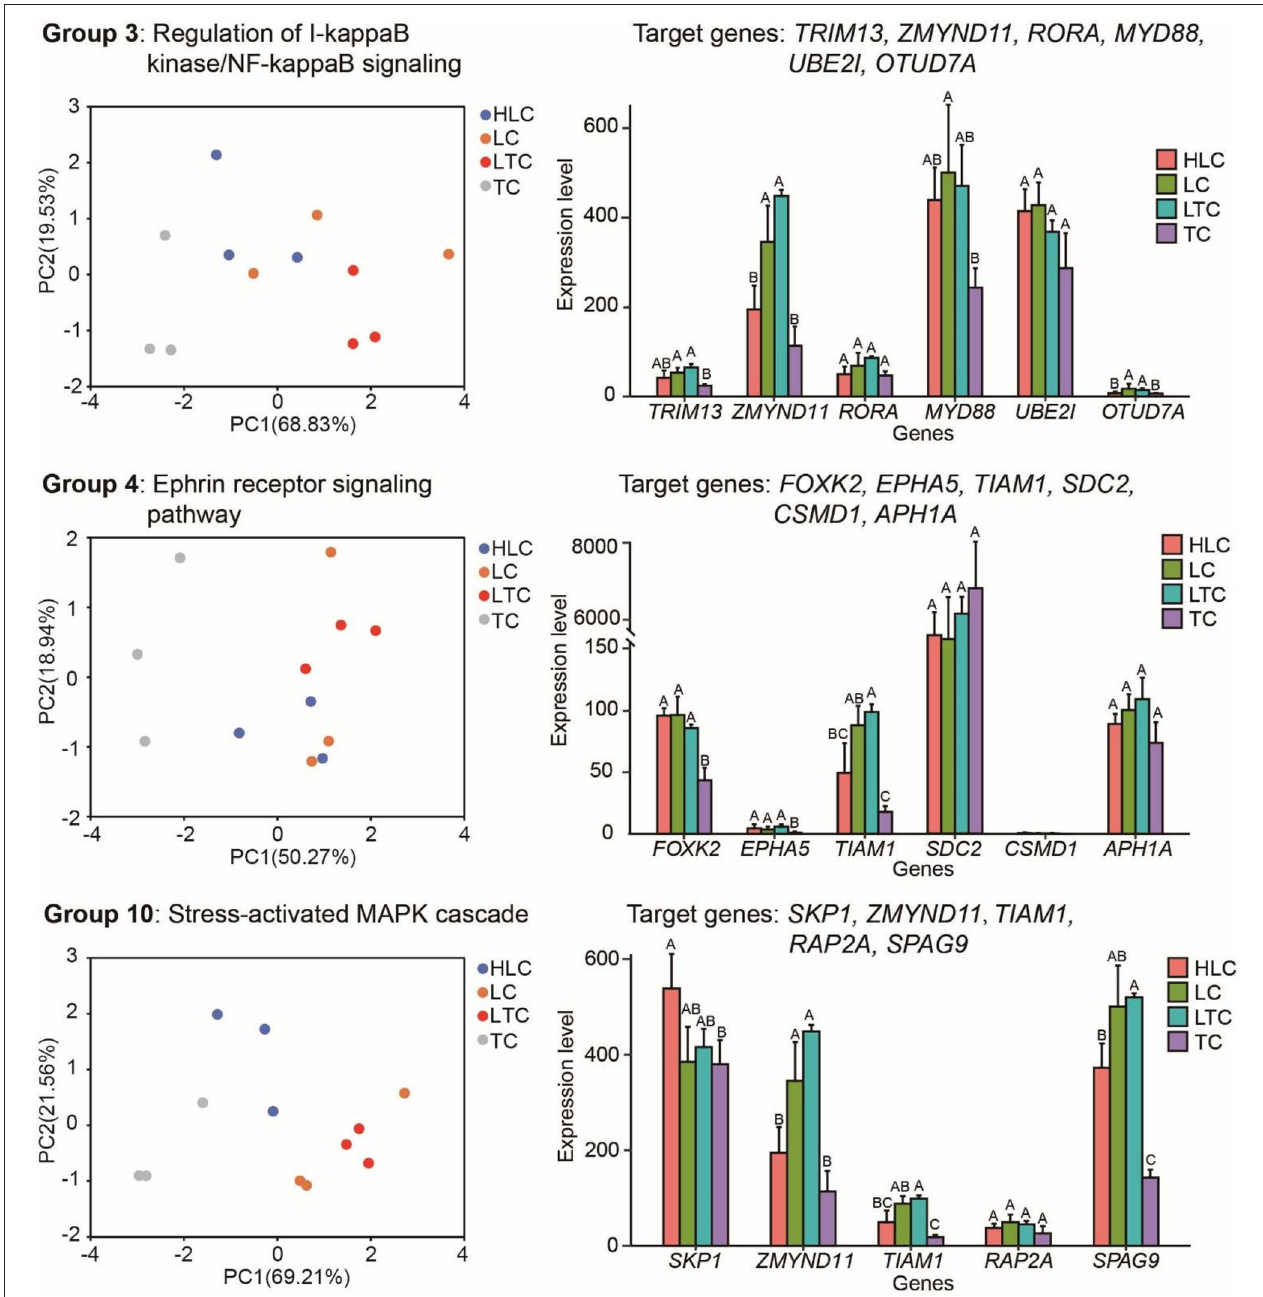
FIGURE 5 | Target genes of miR-10c-5p have different expression patterns between high and low-altitude chickens. The left, middle, and right panels represent the target genes of miR-10c-5p and the pathways these genes are involved in (left panels), PCA plots based on these target genes, and the expression of target genes of miR-10c-5p, respectively. Different letters mean that there is a statistically significant difference between groups ( P ≤ 0.05).